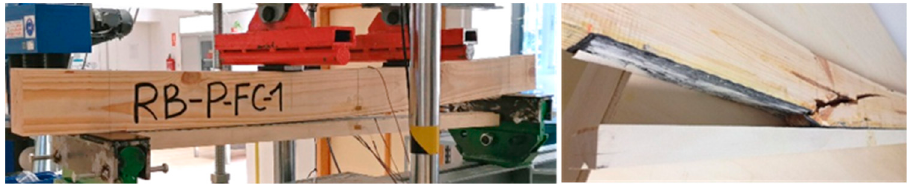
Figure 5. ( Left ) Picture of the delamination during the test at an intermediate load value; ( Right ) pine fracture at the end of the loading. RB_P_FC_1 specimen. Type B.